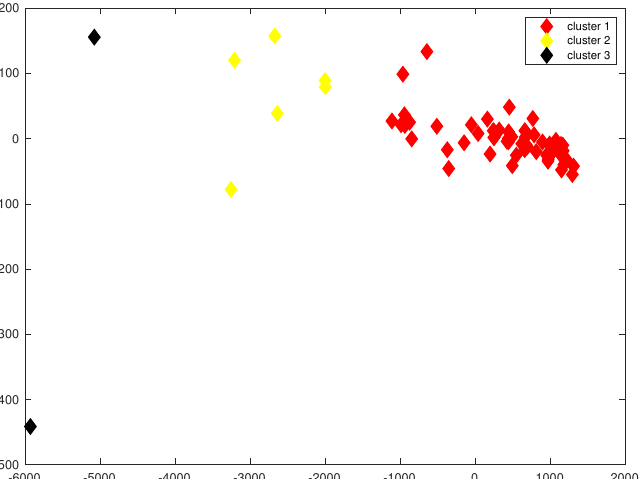
Figure 3. Cluster analysis of all virus families by shortest distance method: red, yellow and black points represent different virus families in three clusters. x -axis and y -axis are the two coordinate axes of the two-dimensional plane. Values on the axes are position coordinates.